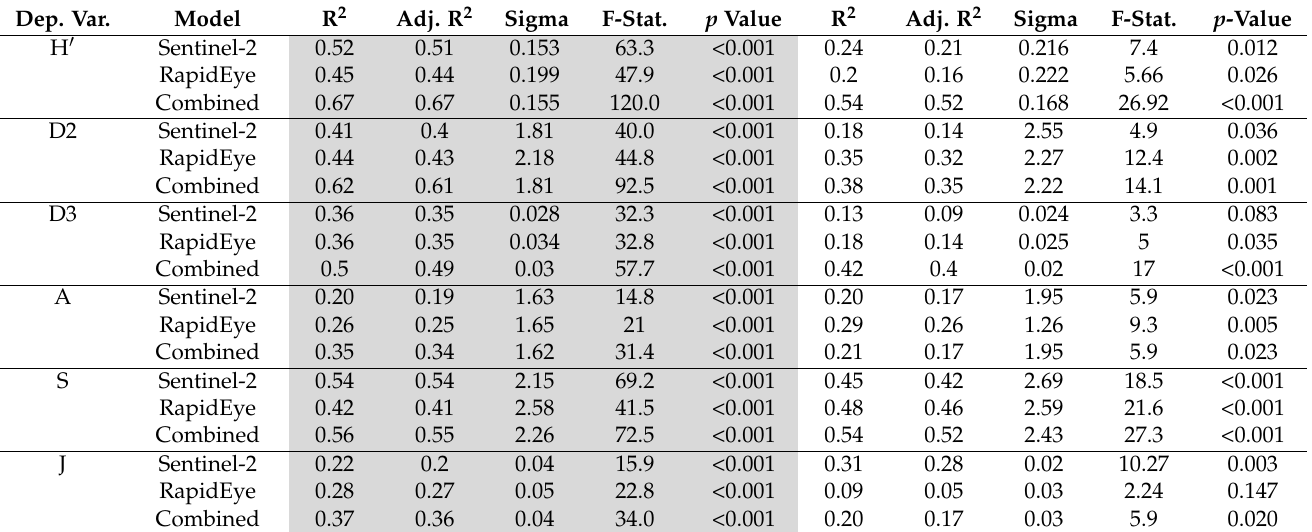
Table 5. Random (grey shaded) and regularly (unshaded) spaced validation 0.10 ha plot predictions from machine learning ensemble models and validation